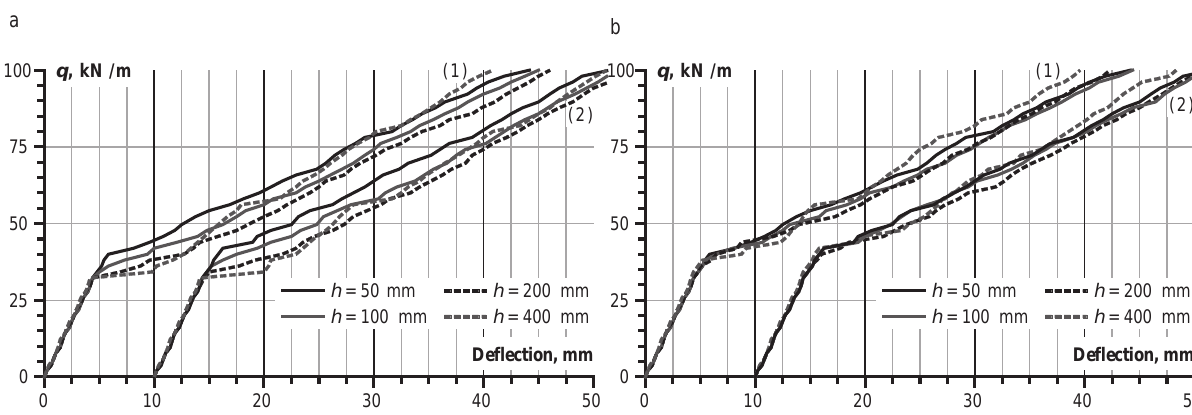
Fig. 7. Mid-span deflection of RC bridge girder calculated using reference (a) and scaled (b) tension-stiffening relationships